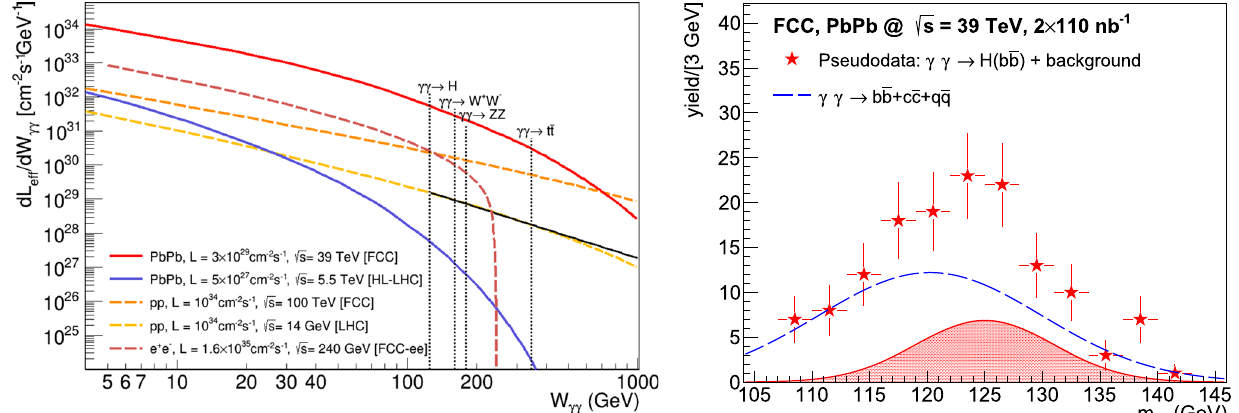
Fig. 16.13 Left: effective luminosities as a function of γγ c.m. energy ( W γ γ ) for five colliding systems at FCC and LHC energies and their nominal luminosities. Right: expected dijet invariant mass distribu-